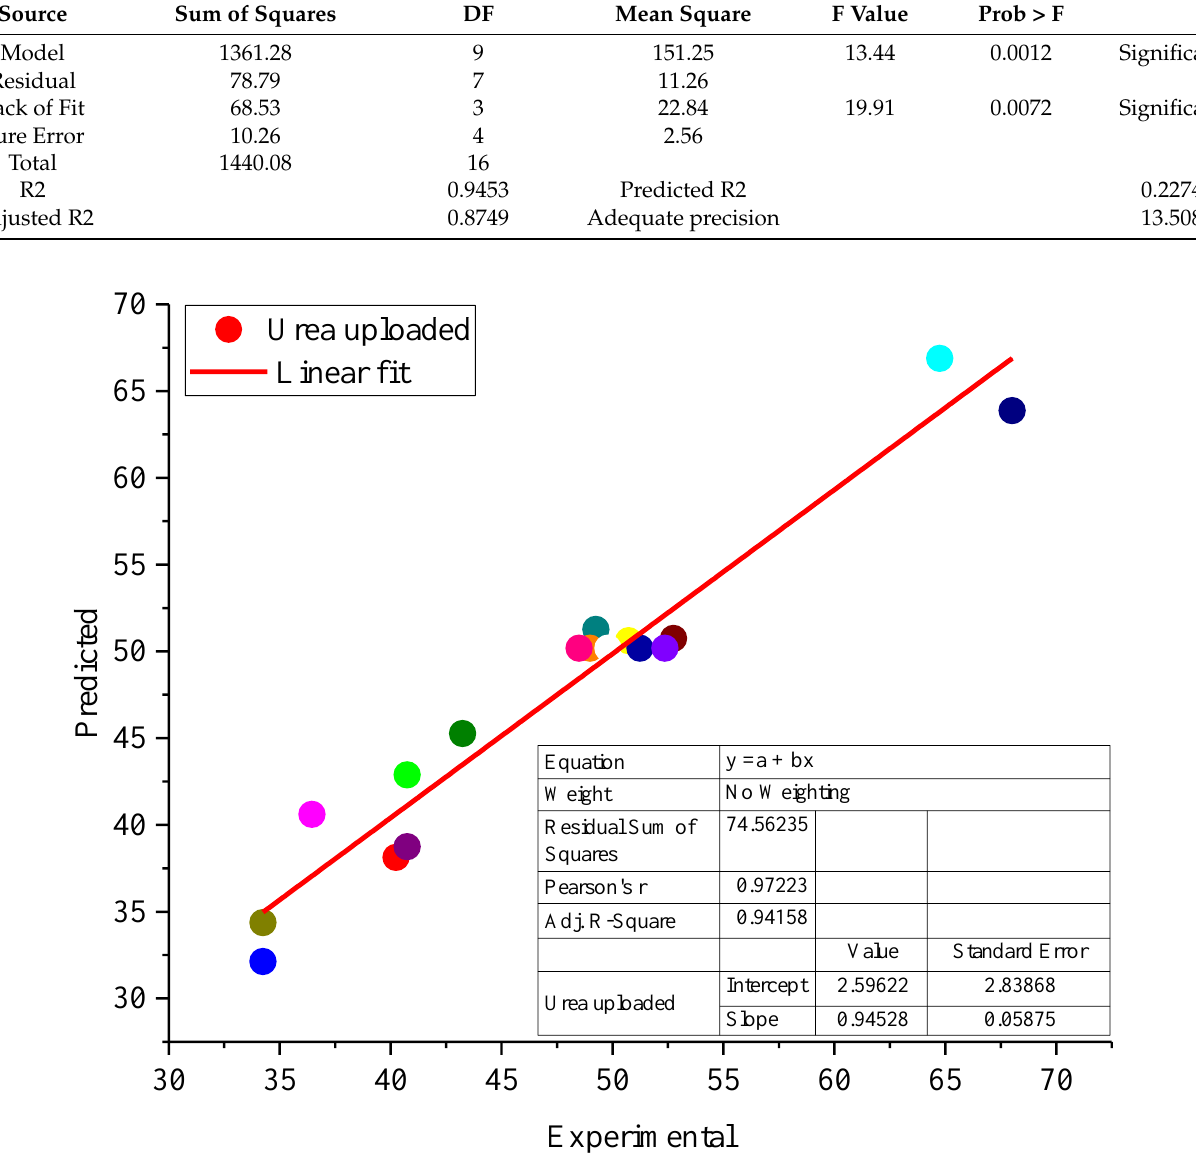
Table 3. ANOVA for response surface quadratic model.